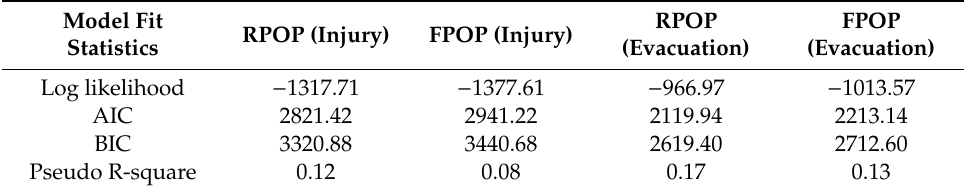
Table 2. Comparison of fit statistics of random-parameters ordered probit (RPOP) and fixed-parameters ordered probit model (FPOP)